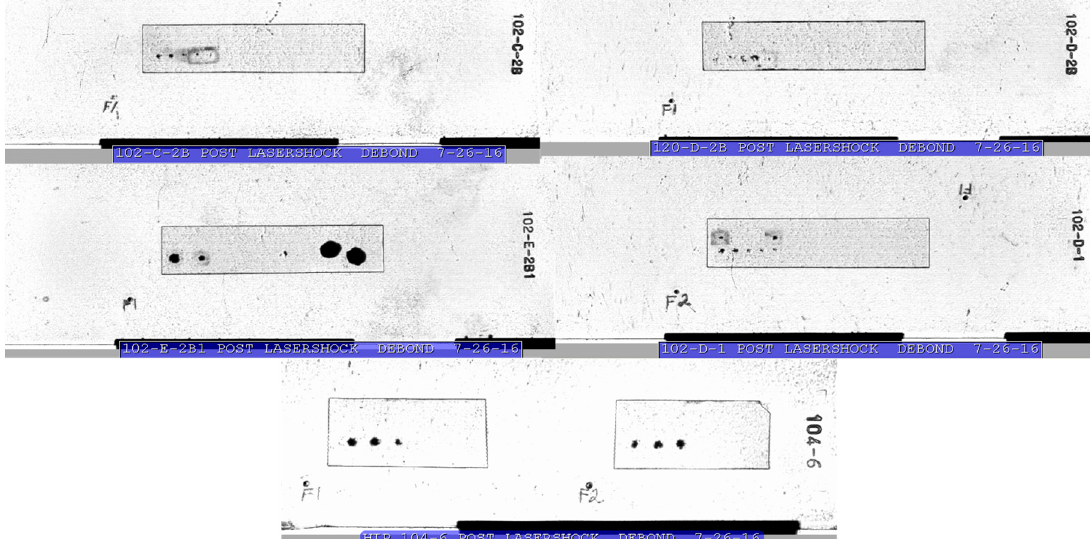
Figure 12 . Ultrasonic C-scan images of the FF fuel plates that have been laser shock tested. The dark regions indicate debonds in interfaces that reflect sound and keeps sound from traveling through the fuel plate to the back side. While the HIP process appears to have healed the coating blisters on foil 21E-2B1, the bond strength is low and the debond areas are large. Note that the exceptionally large debond areas for foil 21E-2B1 corresponds to the blistered side of the foil.